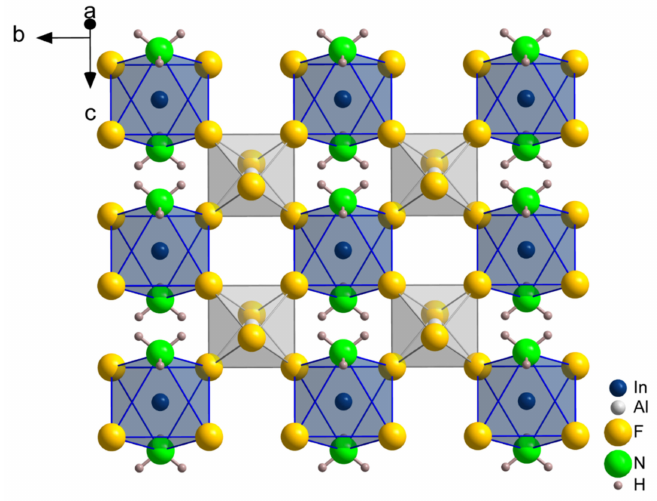
Figure 2. Section of the crystal structure of InAlF 6 (NH 3 ) 2 showing one layer of fluorine-sharing octahedra within the (100) plane.